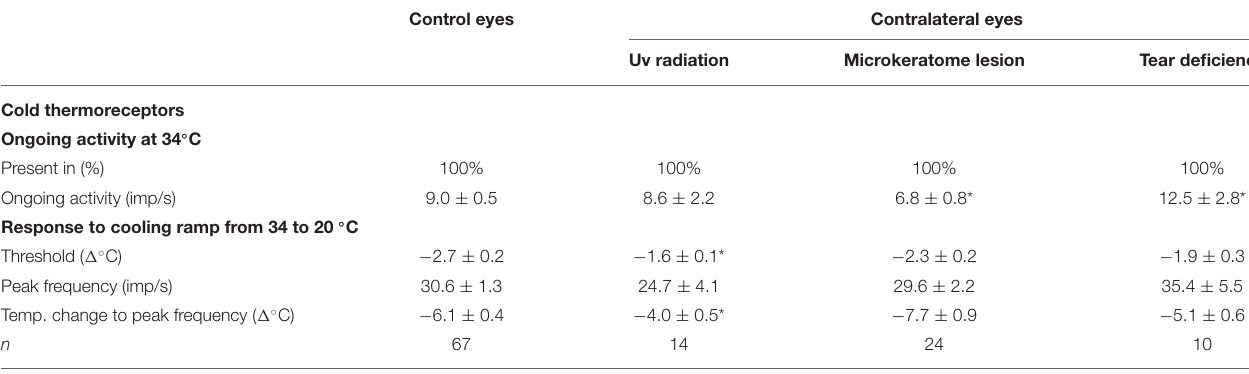
Control eyes Contralateral eyes Uv radiation Microkeratome